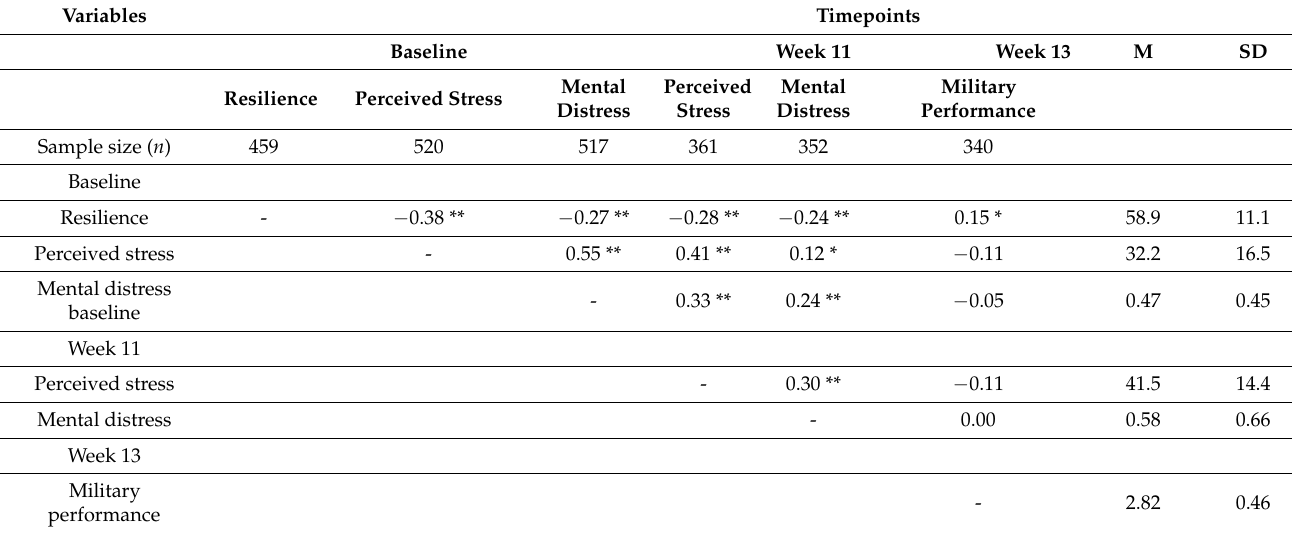
Table 1. A descriptive and correlational overview of resilience at baseline, perceived stress and mental distress at baseline and week 11, and military performance at week